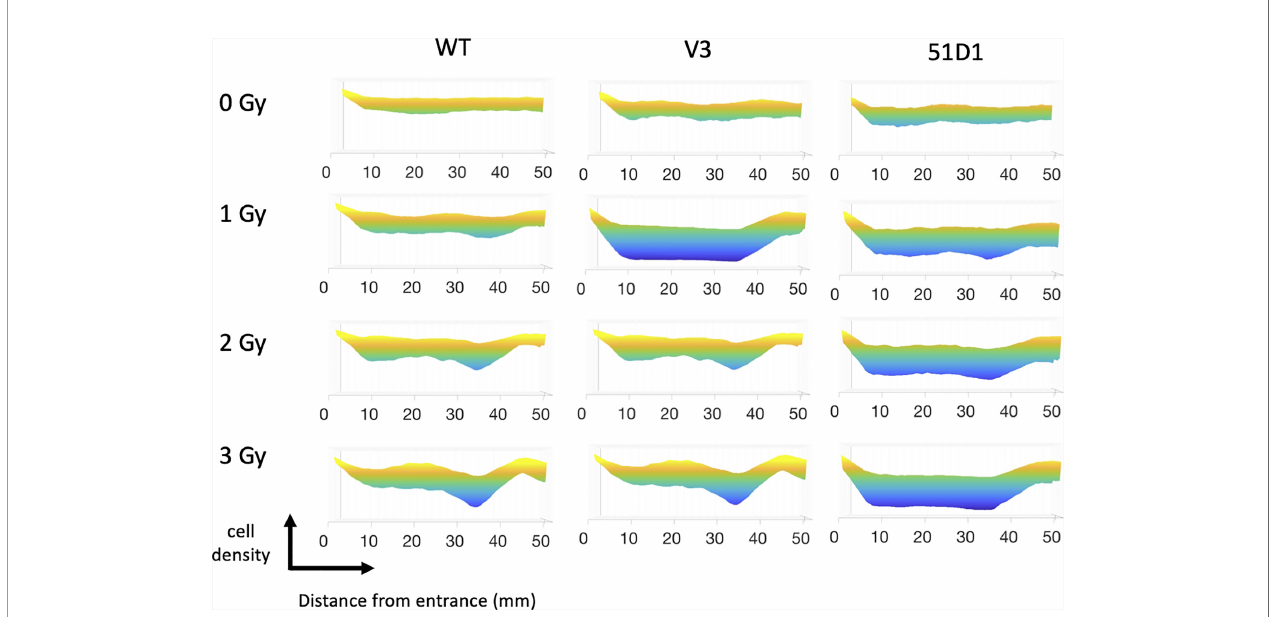
FIGURE 2 | MATLAB image analysis of cell survival after proton irradiation. Yellow color indicates more cells; blue color indicates less cells. Three fl asks were merged for analysis.